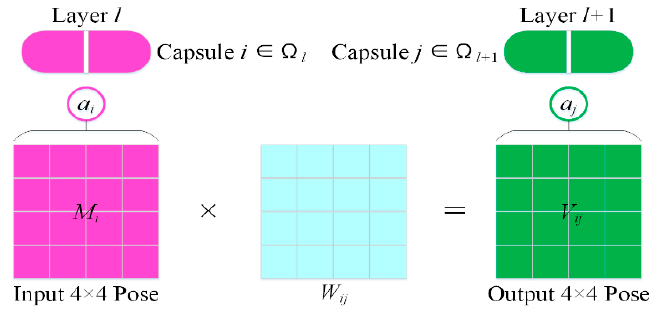
Figure 3. Illustration of the matrix capsule features with the pose matrix.